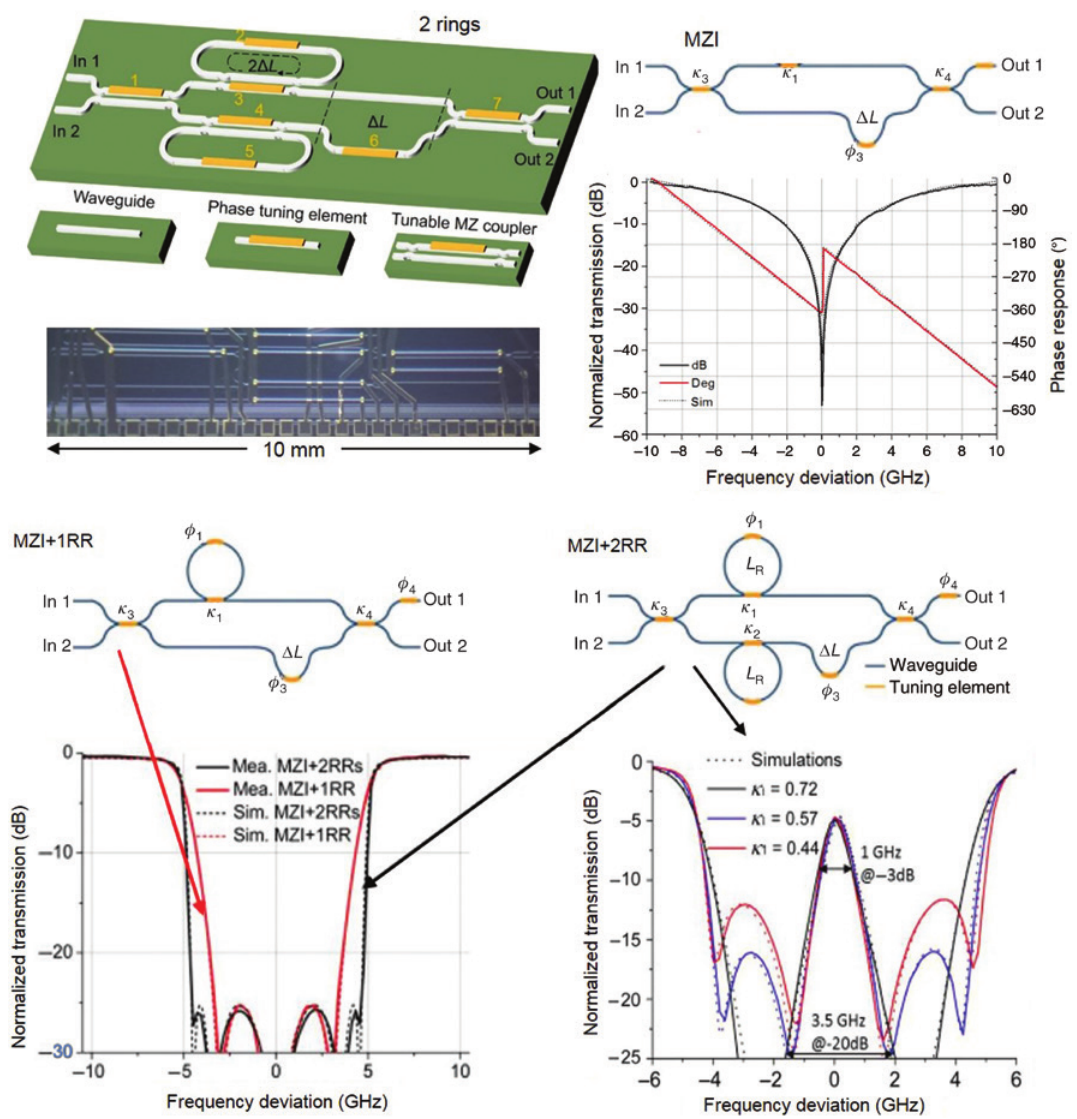
Figure 12: Design and realization of a highly reconfigurable RAMZI circuit: implementations of various optical filters using a regular